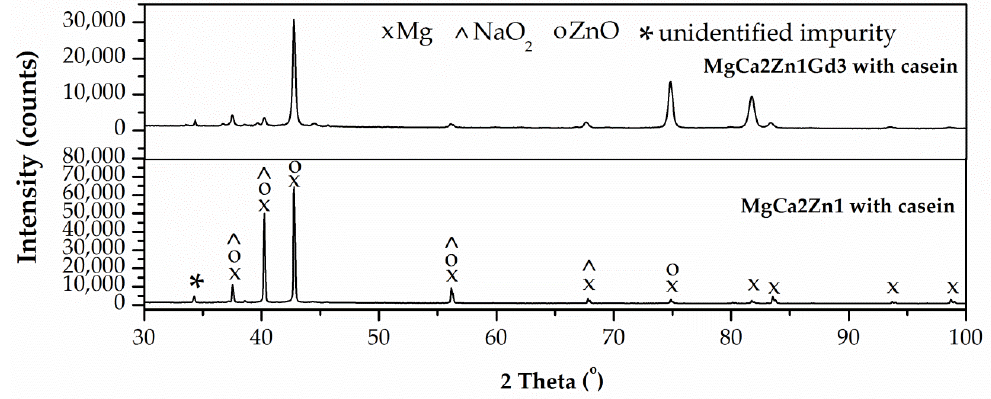
Figure 6. X-ray diffraction patterns of the conversion casein coatings applied onto MgCa2Zn1 and MgCa2Zn1Gd3 alloys.